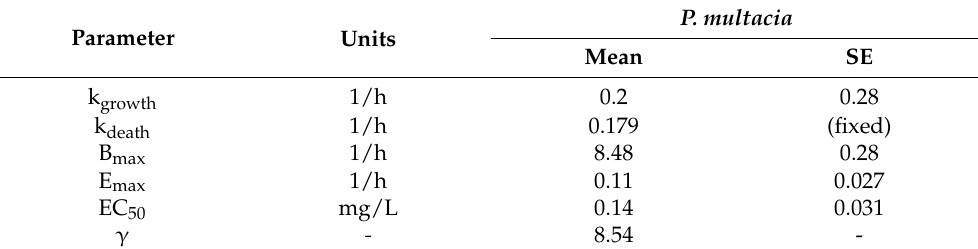
Table 5. Estimation of PD parameters obtained from a model of the time-killing experiment of CEF against P. multacia